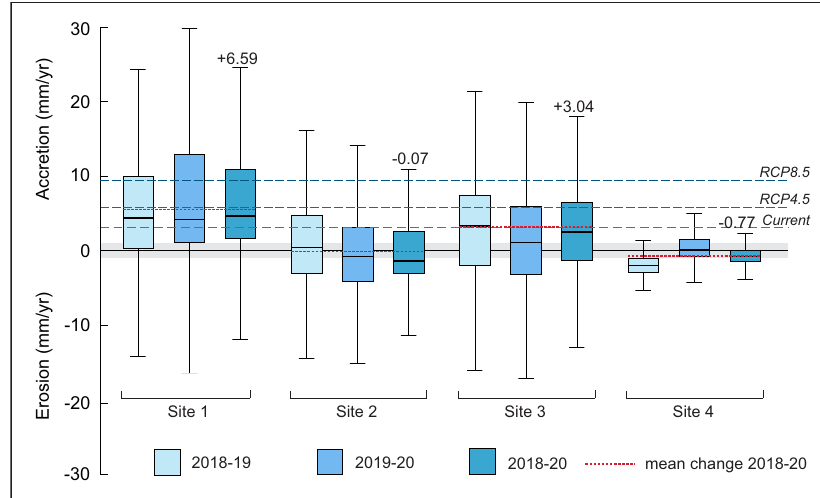
Fig. 4 Comparison of reef accretion rates at outer reef fl at sites in Huvadhoo atoll with current and future projections of sea-level rise. Results for each site are presented for each year and the aggregated annual mean across the experimental period. Sea-level rise scenarios presented are the contemporary rate of change in the southern Maldives of 3.46 ± 0.25 mm.y − 1 , and the global scenarios of RCP 4.5 = 6.9 mm.y − 1 and RCP 8.5 = 9.6 mm.y − 1 . Note, rates of change at site four sit within the margin of error of CRAF measurements and indicate no net change. Boxes represent the interquartile range from the 25 th to 75 th percentiles, horizontal black line is the median, whiskers represent the minimum and maximum